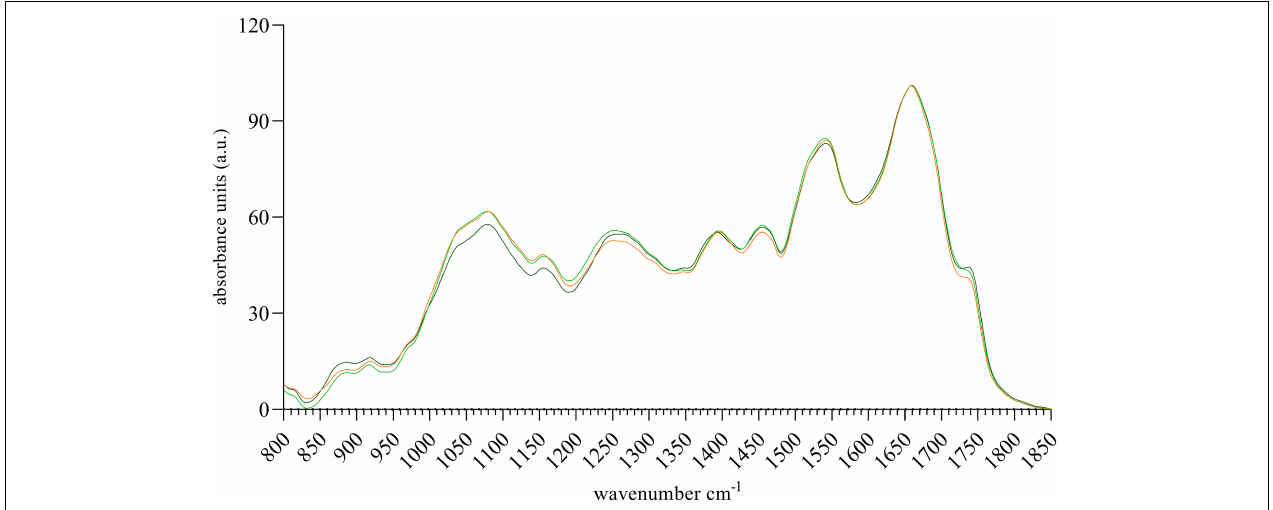
FIGURE 4 | FTIR spectra of biomass derived from Scotiellopsis reticulata (UFA-2) harvested after growth for 5 days in the presence of methanol (1.5% (v/v), light green or 3.0% (v/v), dark green). The control culture (orange) was grown photoautotrophically in the absence of external carbon